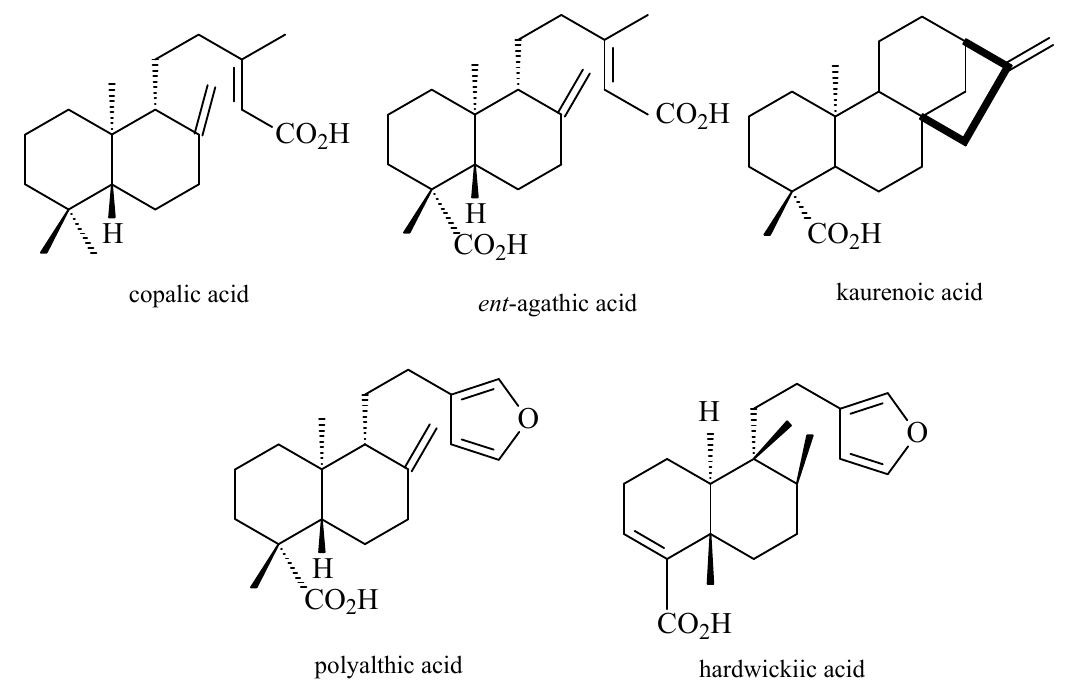
Figure 2. Main diterpenes detected in copaiba